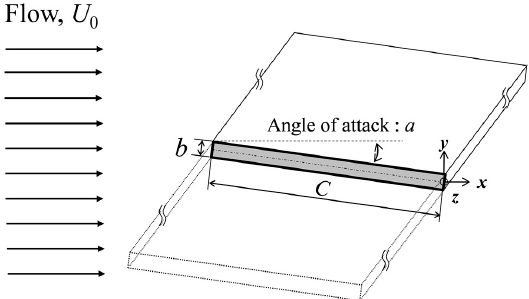
Figure 2. Schematic of the oscillating plate.